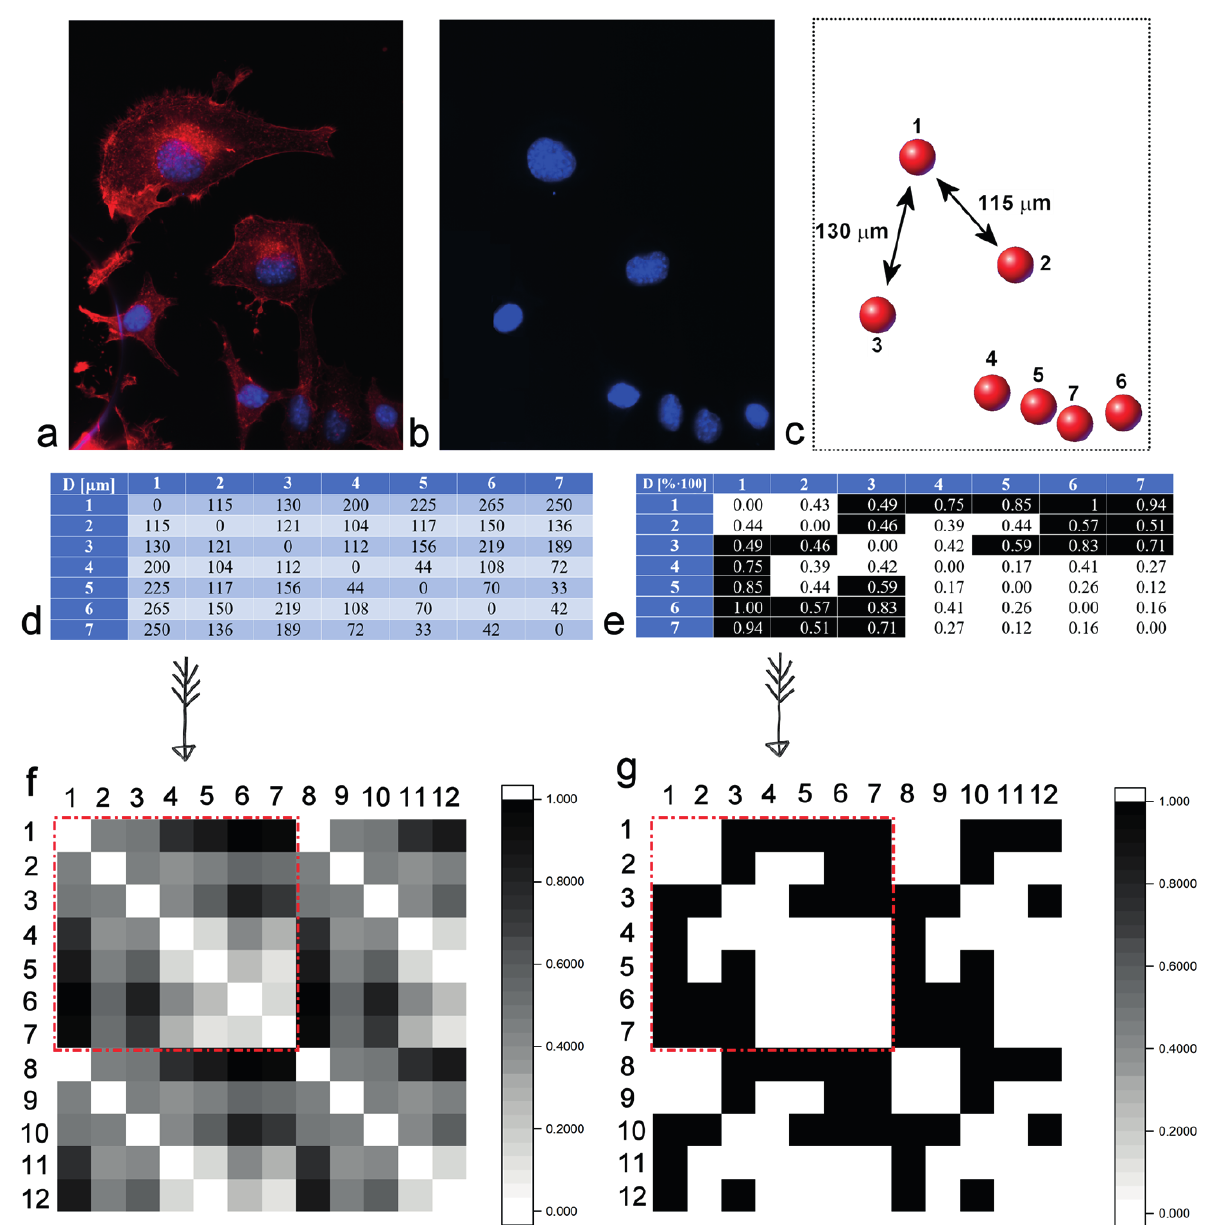
Figure 3. A representative optical image of K7M2-pCl osteosarcoma cells fluorescently stained in red for f-actin and blue for the nucleus (a). The image showing only the positions of the cell nuclei (b) is converted to dots corresponding to centers of nuclei (c) and used to meas- ure the pairwise distances between cells (c). These distances are used to plot an absolute distance matrix (d) and a relative one, where dis- tances are normalized to the largest distance in the image (e). The former matrix can be converted to an absolute heat map (f). To digitalize one such heat map, distances ranging from 0 to the matrix average are assigned 0 value (white), while distances ranging from the matrix average to 100 % are assigned the value of 1 (black) in order to create a matrix (g) that is comparable for similarity with the sona drawing patterns based on the methodology described in Figs.4 and 5. The distance matrix heat maps were of the n x n dimensions, where n is the number of cells used to construct the matrix. Here, n = 7 and the basic 7 x 7 patterns obtained from the distance matrices are demarcated in (f) and (g) by the red dashed squares. Their extension resulted in 12 x 12 checkerboard patterns (f, g) comparable against the identically dimensioned sona drawing